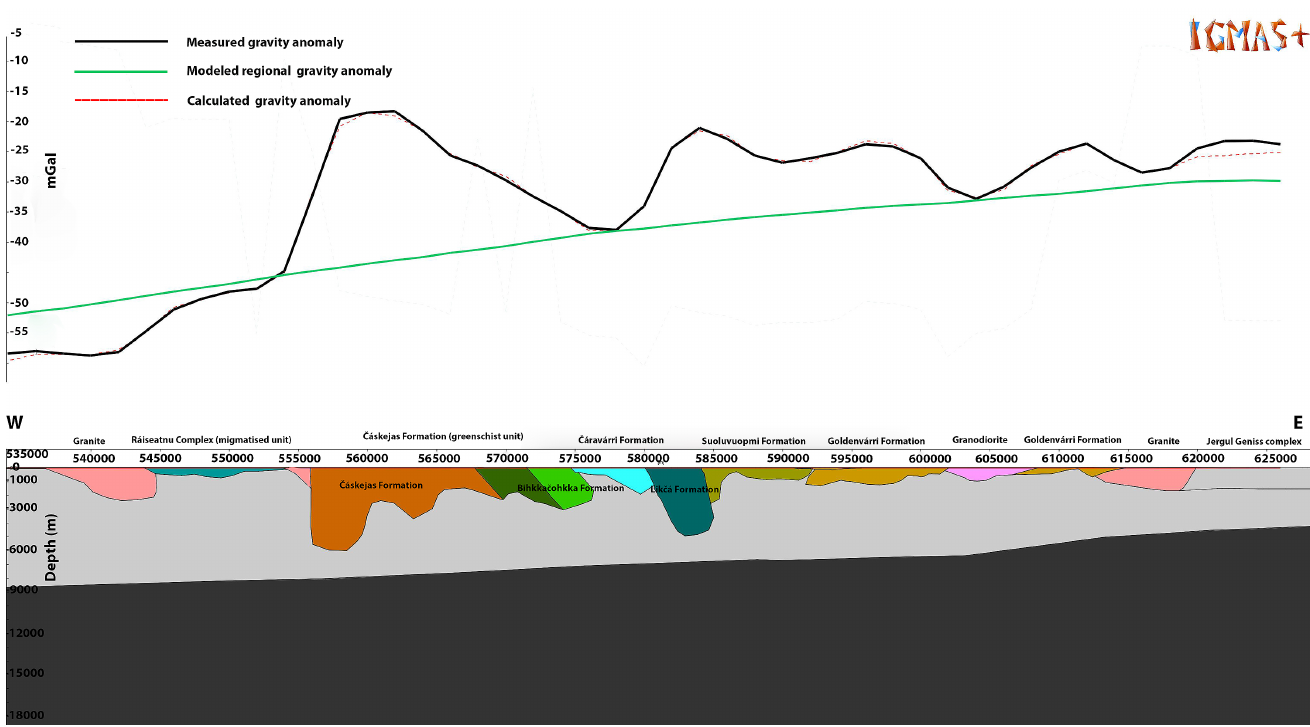
Figure 17. Selected vertical slice 4 (P4) through the 3D density/structural model in Fig. 12. The black line shows the measured data. The dashed red line represents the modelled data while the green line shows the regional trend.